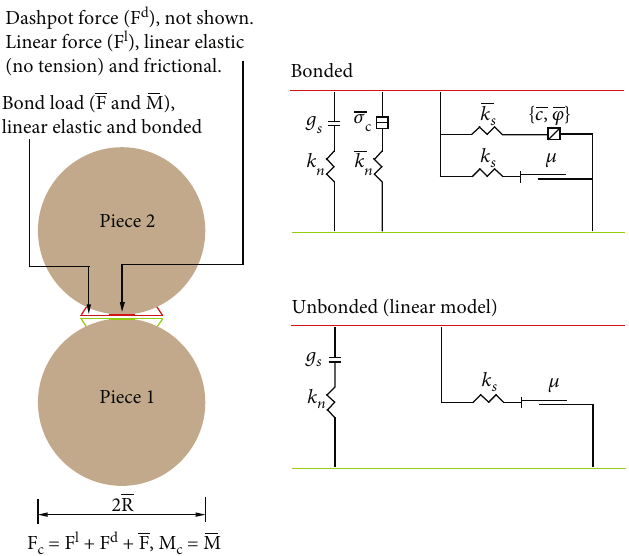
Figure 1: Mechanical behavior of parallel bond model [31].